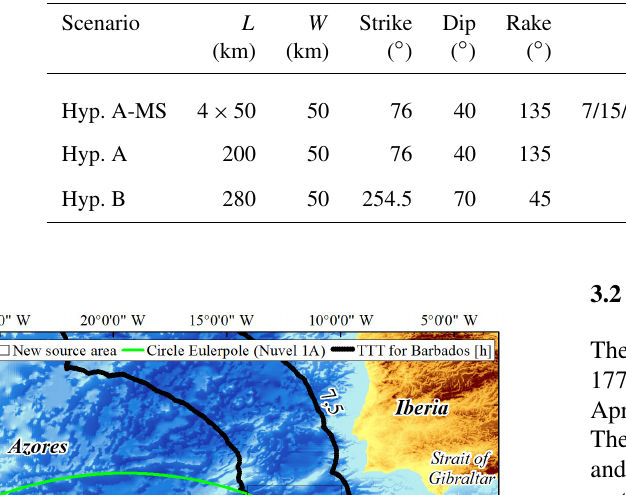
Table 2. The fault dimensions and parameters used herein investigate candidate sources of the 1761 event. We describe hypotheses (Hyp.) A-MS, A and B by the fault parameters length ( L ), width ( W ), strike, dip, rake, slip and depth. The slip values for hypothesis A-MS are listed for each segment from west to east. Additionally, we present the moment magnitude (Mag.), the assumed shear modulus ( µ ) and the focal mechanism.